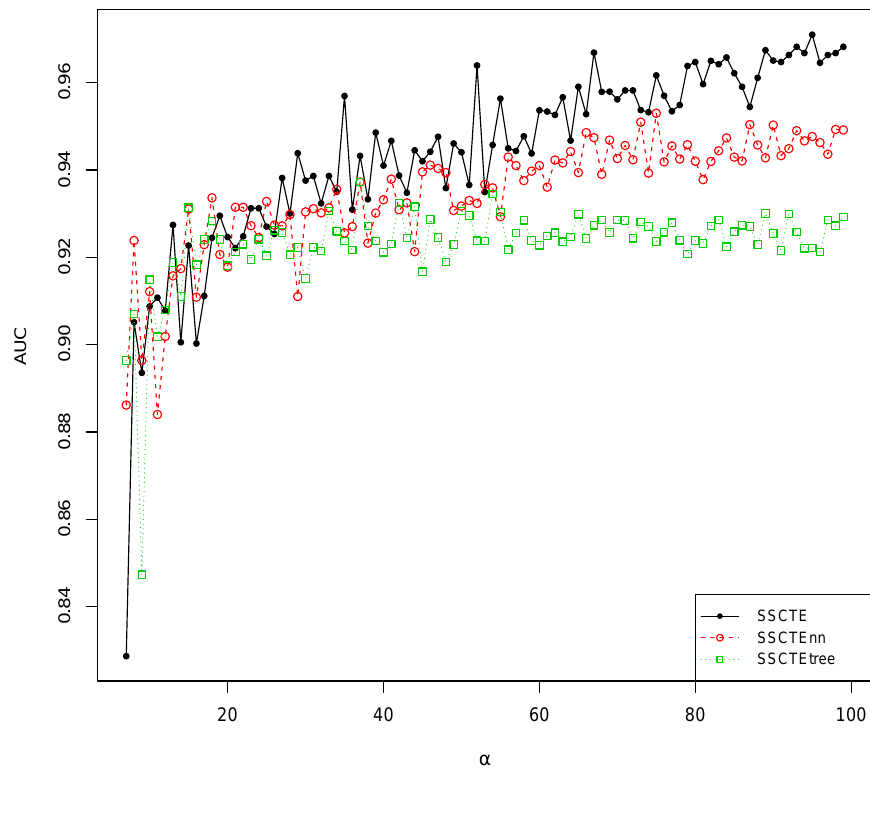
Figure 7. SSCTE variants’ performance in terms of